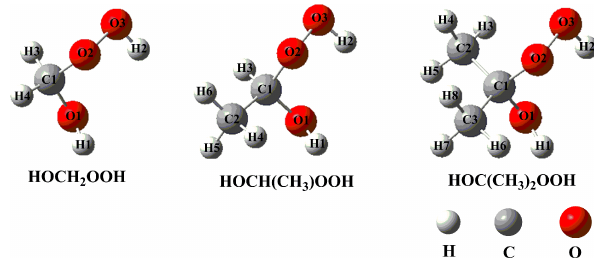
Figure 1. The structures of distinct